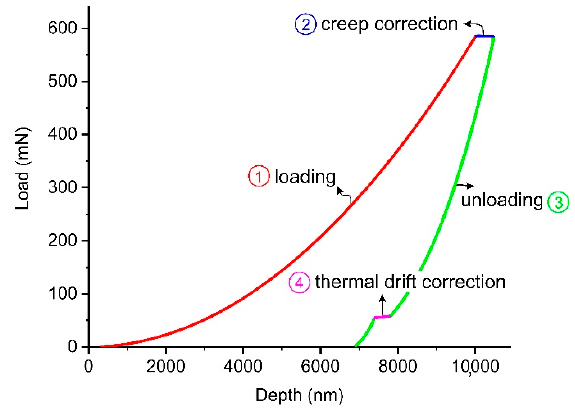
Figure 2. Typical load-displacement curve for the nanoindentation tests.